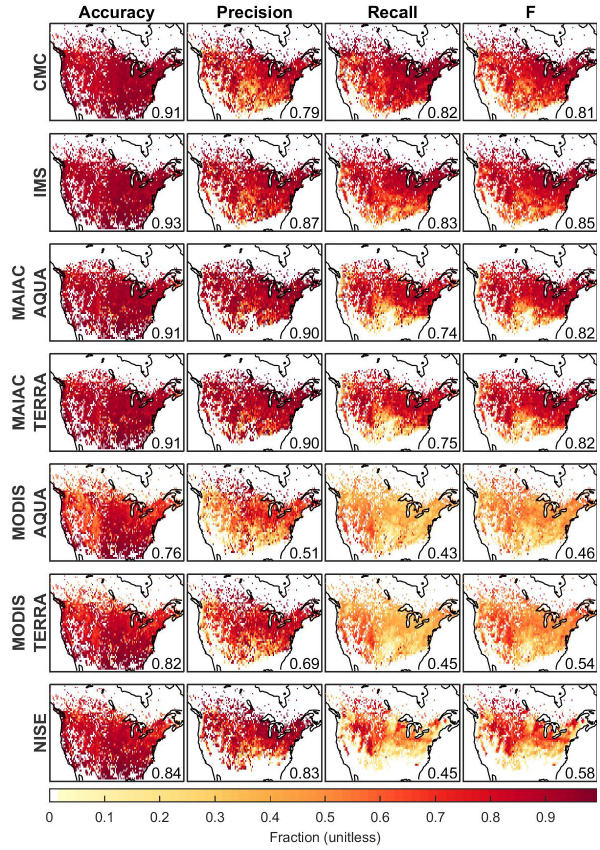
Figure 5. Statistical metrics to evaluate snow cover products. All data sets are gridded at 4km resolution. White space indicates that no ground stations